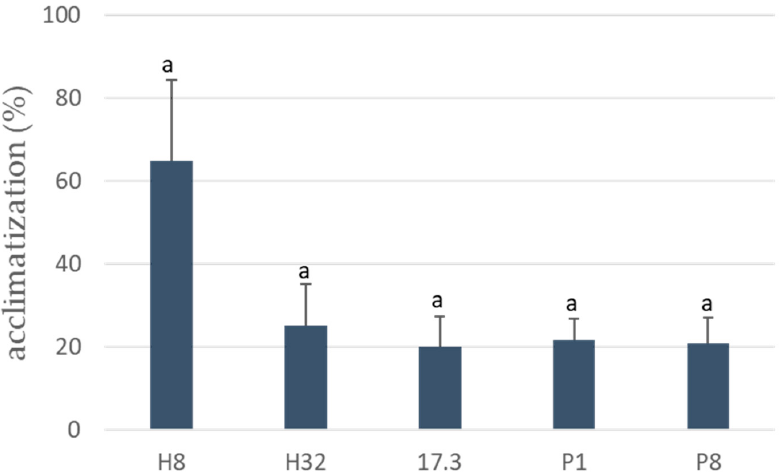
Figure 2. Acclimatization percentages of five different genotypes (H8, H32, 17.3, P1, and P8). The letter “a” indicates that there are no statistical differences between genotypes. letter “a” indicates that there are no statistical differences between